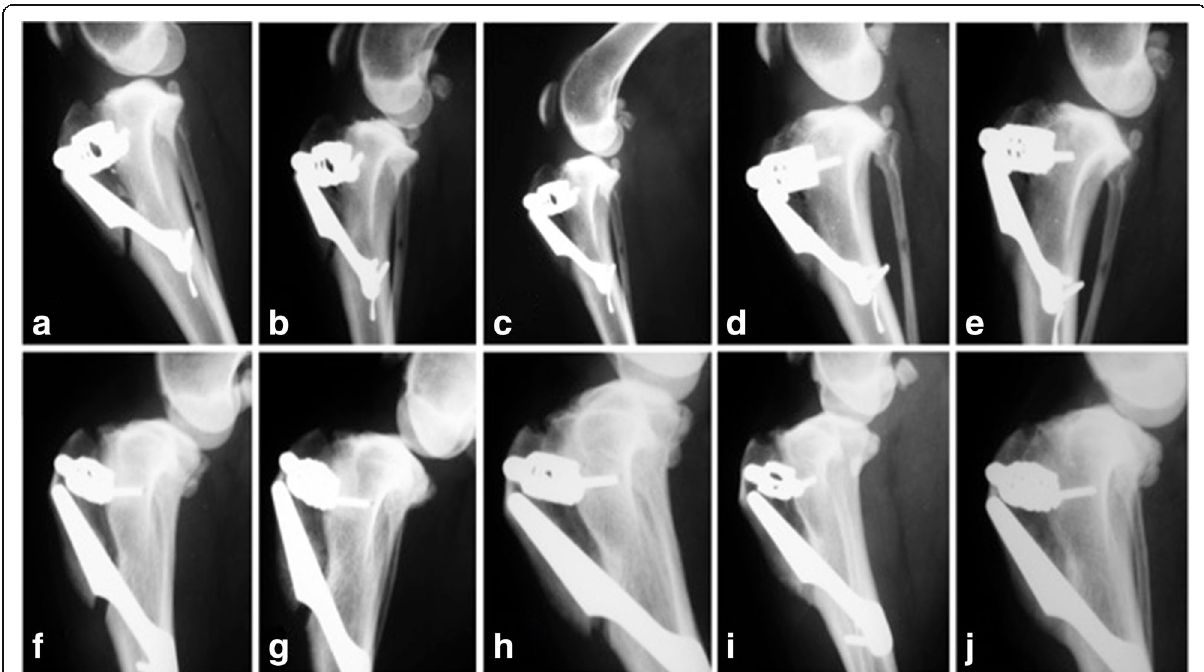
Fig. 5 Radiographs showing the periods evaluated and the scores. Images a , b , c , d and e represent animals of the GT, respectively, in the periods of 15, 30, 60, 90 and 120 days. Images f , g , h , i and j represent GC animals, respectively, in the periods of 15, 30, 60, 90 and 120 days. Score II ( a ), Score III ( b , f and G), Score IV ( c , d , e , h , i and j )